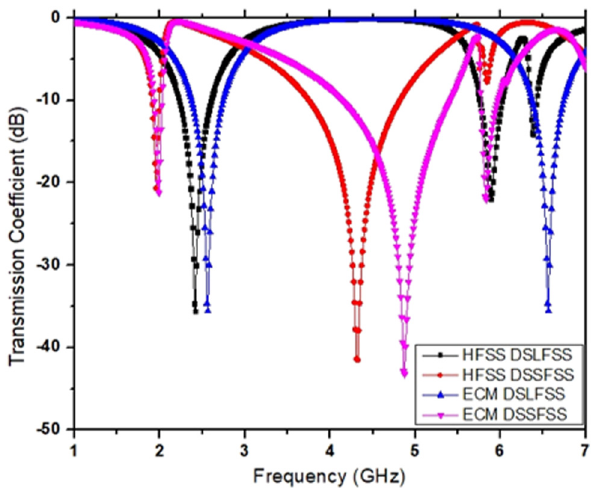
Figure 7: Comparison of the scattering parameters of the CPFSS structures using ECM and FEM ( HFSS ) .